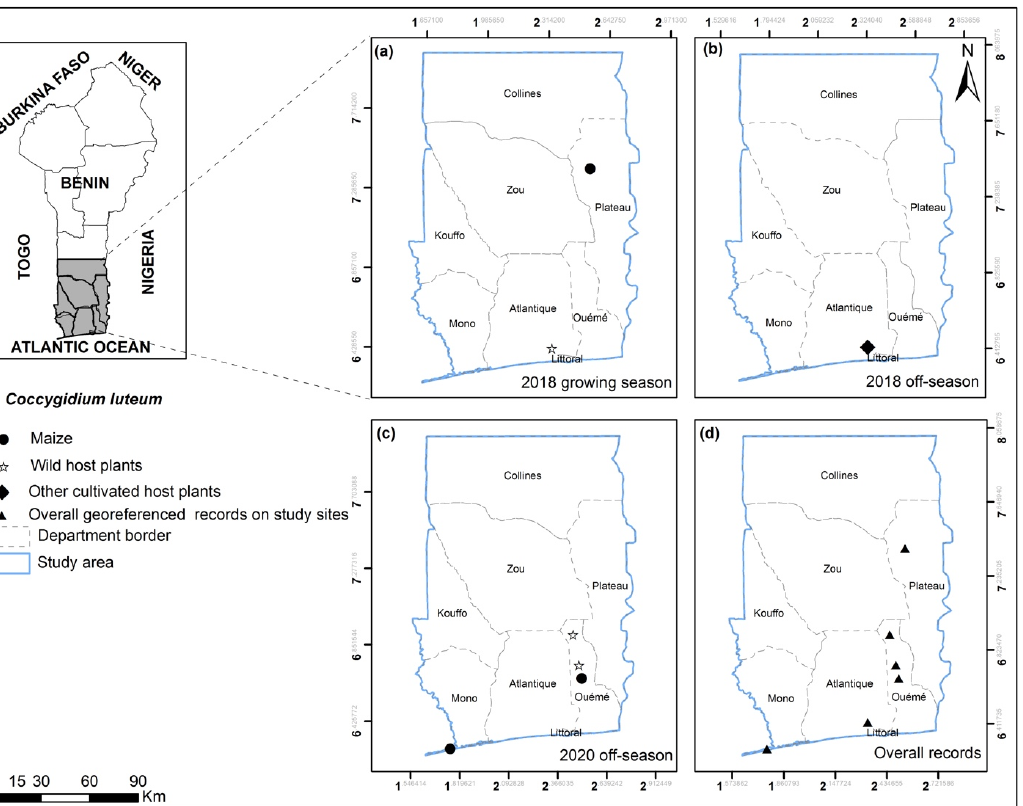
Figure 6. Coccygidium luteum georeferenced records on maize, wild and other cultivated host plants for the years 2018 and 2020 on the study sites for growing ( a ) and off ‐ seasons ( b , c ) in southern and central Benin ( d ). No C. luteum were found in 2019.